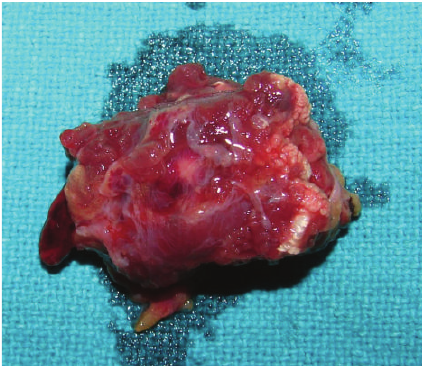
Figure 10: Gross specimen appeared purplish red with a feeder vessel.